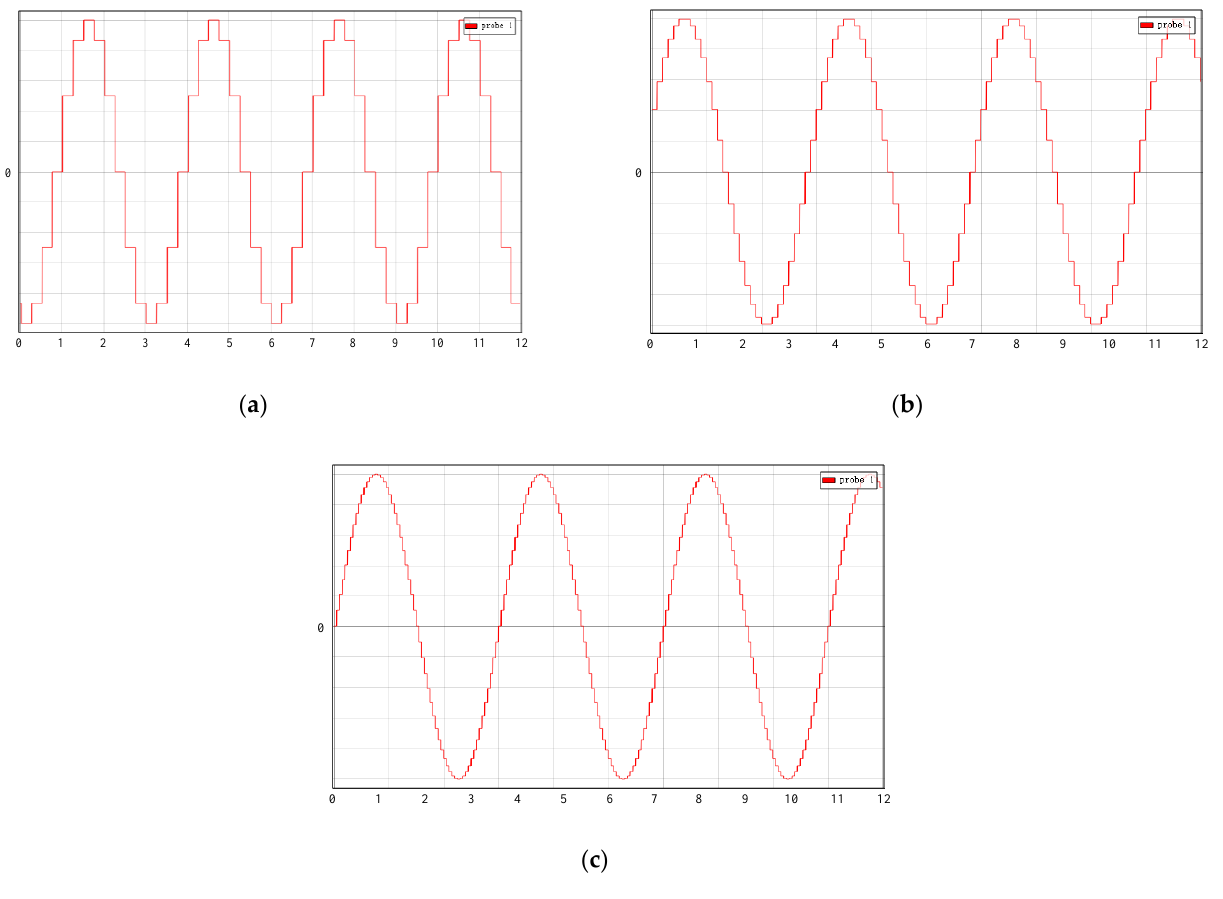
Figure 4. Data acceptance waveforms at different time intervals. ( a ) Time interval is 250 ms; ( b ) Time interval is 10 ms; ( c ) Time interval is 2